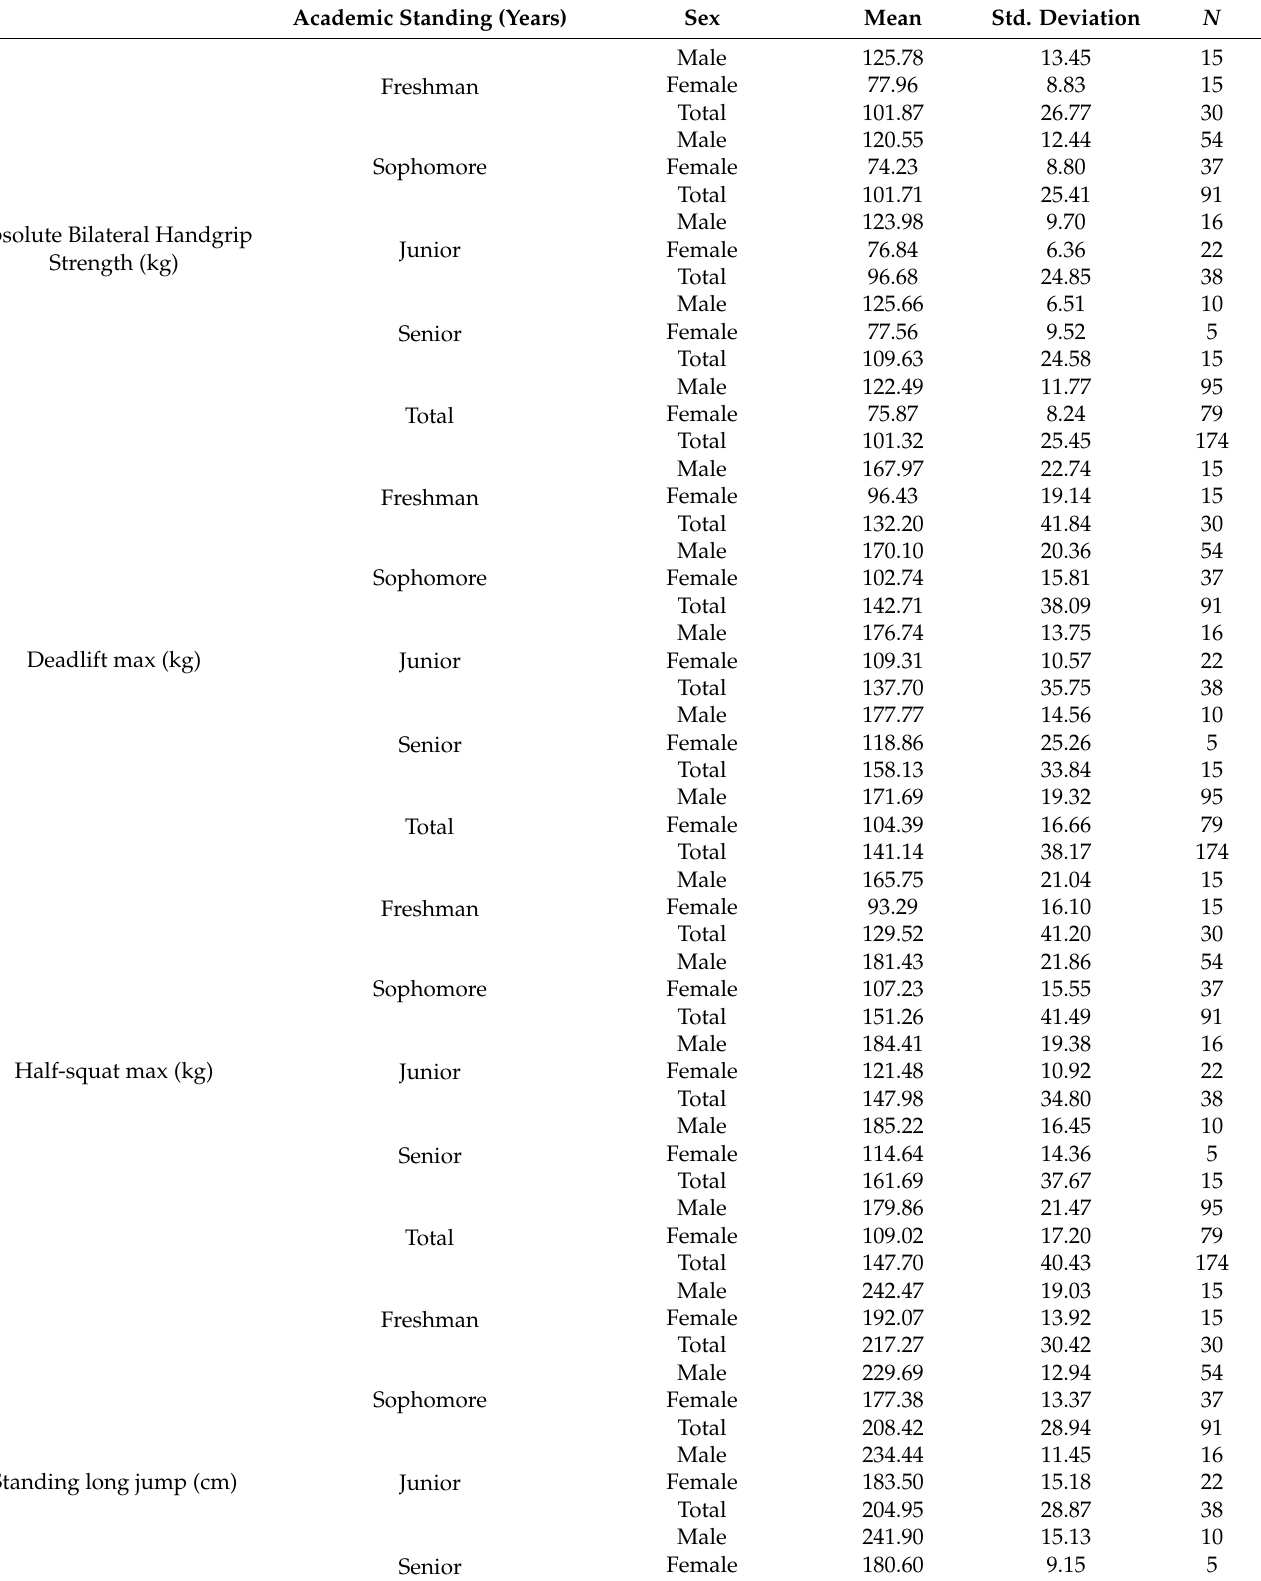
Table 2. Descriptive Statistics for examined